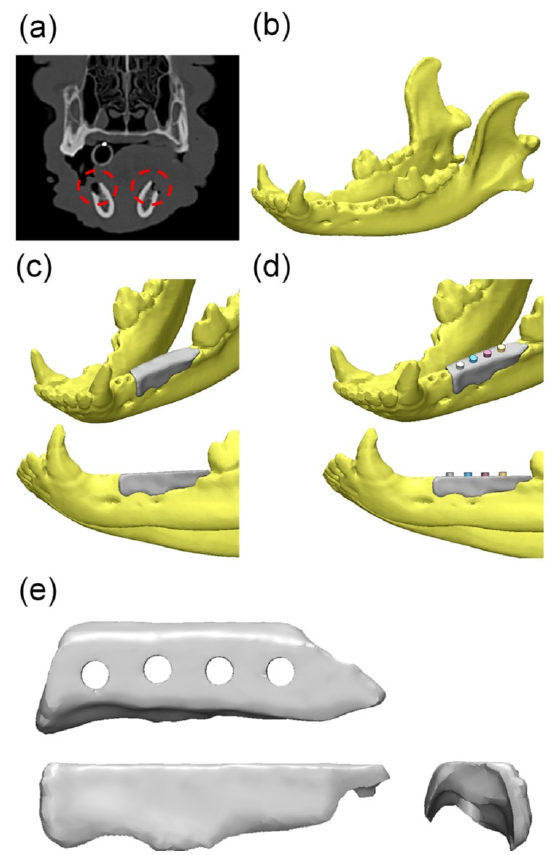
Figure 4. Overall modeling process of the implant guide scaffold: ( a ) Red dashed line: alveolar bone defect of mandible; ( b ) 3D modeling process of CT image; ( c ) 3D scaffold cover of the defect area; ( d ) 4 thru holes for inserting implant fixture; ( e ) Final model of implant-guided scaffold [89]. Copyright 2017 MDPI.